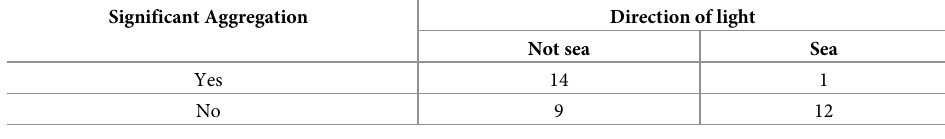
Fisher’s exact test, P <